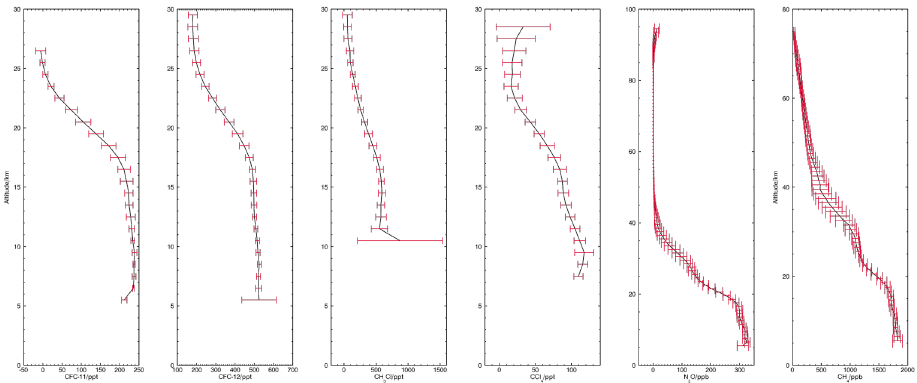
Figure C4 The mean vertical profile of CFC-11, CFC-12, CH3Cl, CH4 & N2O, calculated using data from 2009 between 45° and 30° North Fig. C5. The mean vertical profile of CFC-11, CFC-12, CH 3 Cl, CCl 4 , N 2 O and CH 4 , calculated using data from 2009 between 45 ◦ and 30 ◦ N.